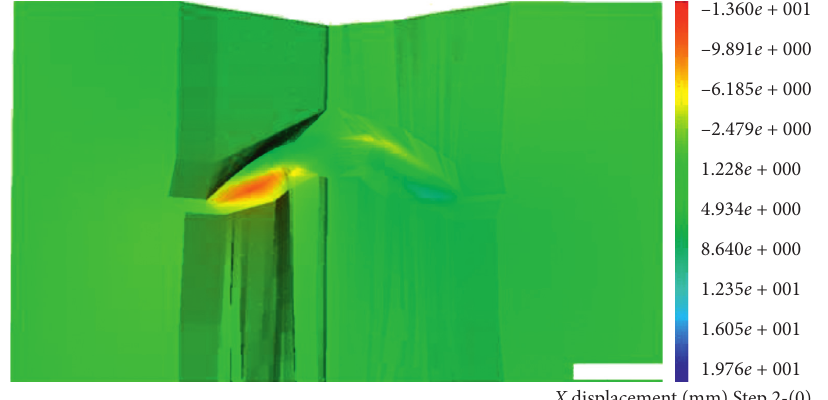
Figure 10: Transverse displacement of the foundation under working condition 4 (unit: mm).